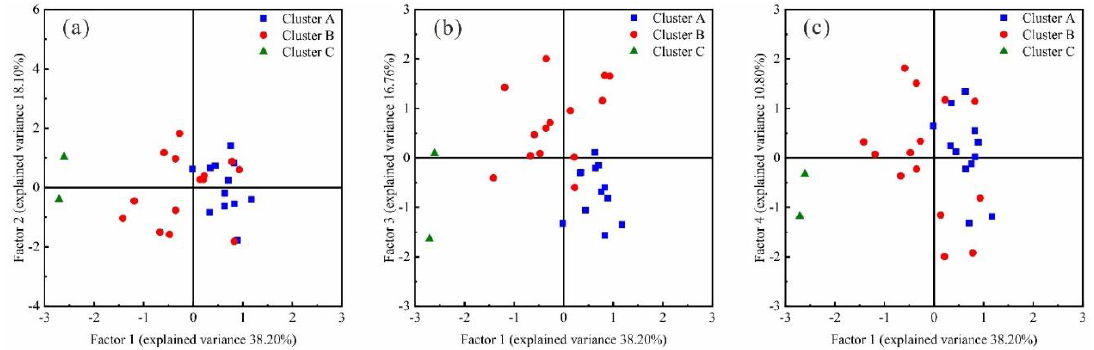
Figure 9. Scatter plots of factor scores: ( a ) Factor 1 vs. Factor 2; ( b ) Factor 1 vs. Factor 3; ( c ) Factor 1 vs. Factor